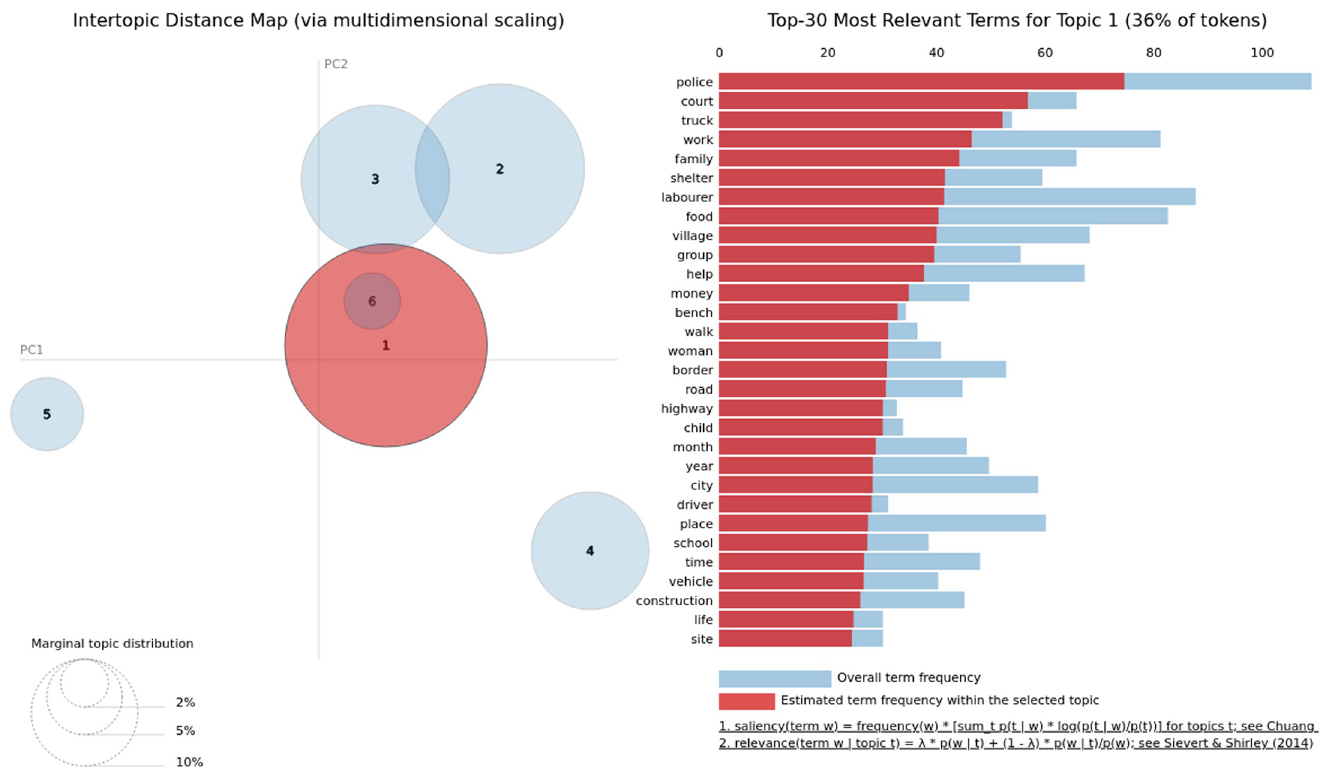
Fig 6. Illustrating the top 30 salient terms present in first topic identified using TF-IDF model employed on articles. The bubble chart visualises the overlap in various topics plotted in a two dimensional (components) space.